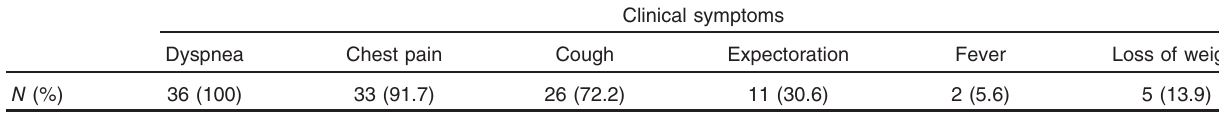
Table 2 Clinical data among studied patients